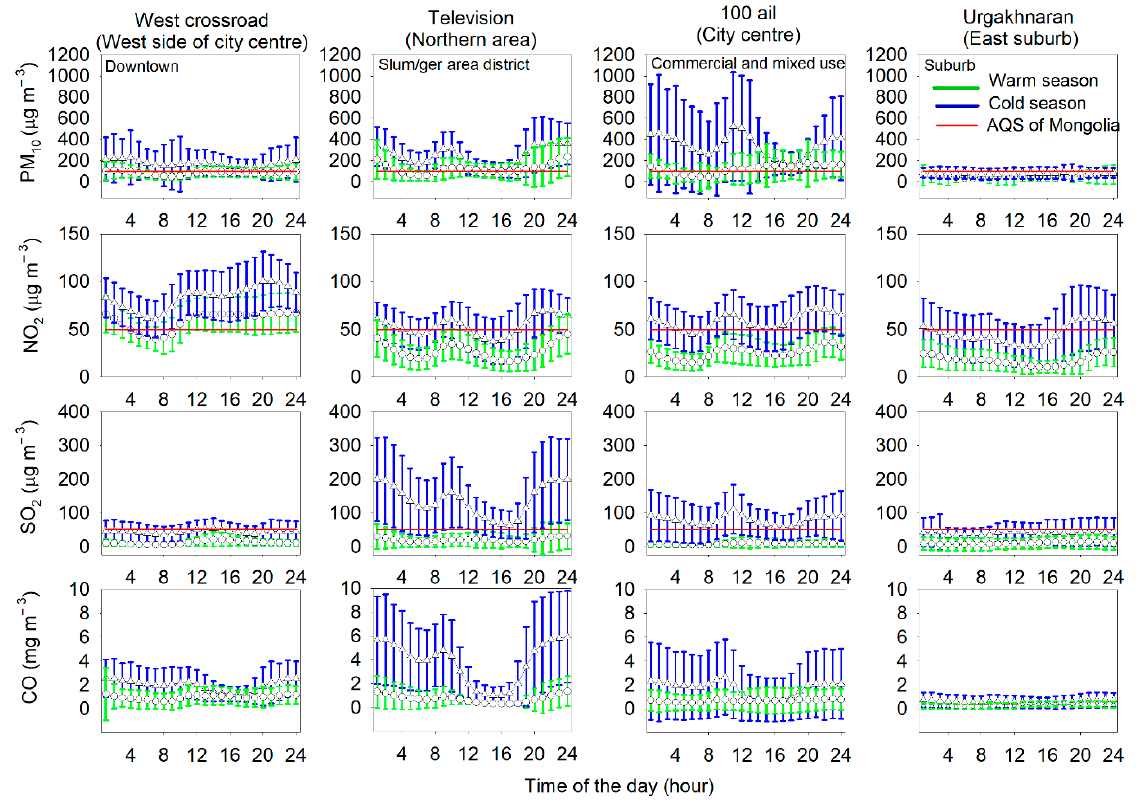
Figure 13. Diurnal variations in air pollutants in the different land use areas of Ulaanbaatar city in the warm and cold seasons from 2019 to 2020. The blue and green lines correspond to the cold and warm seasons; the red line is the Mongolian AQS for pollutants.